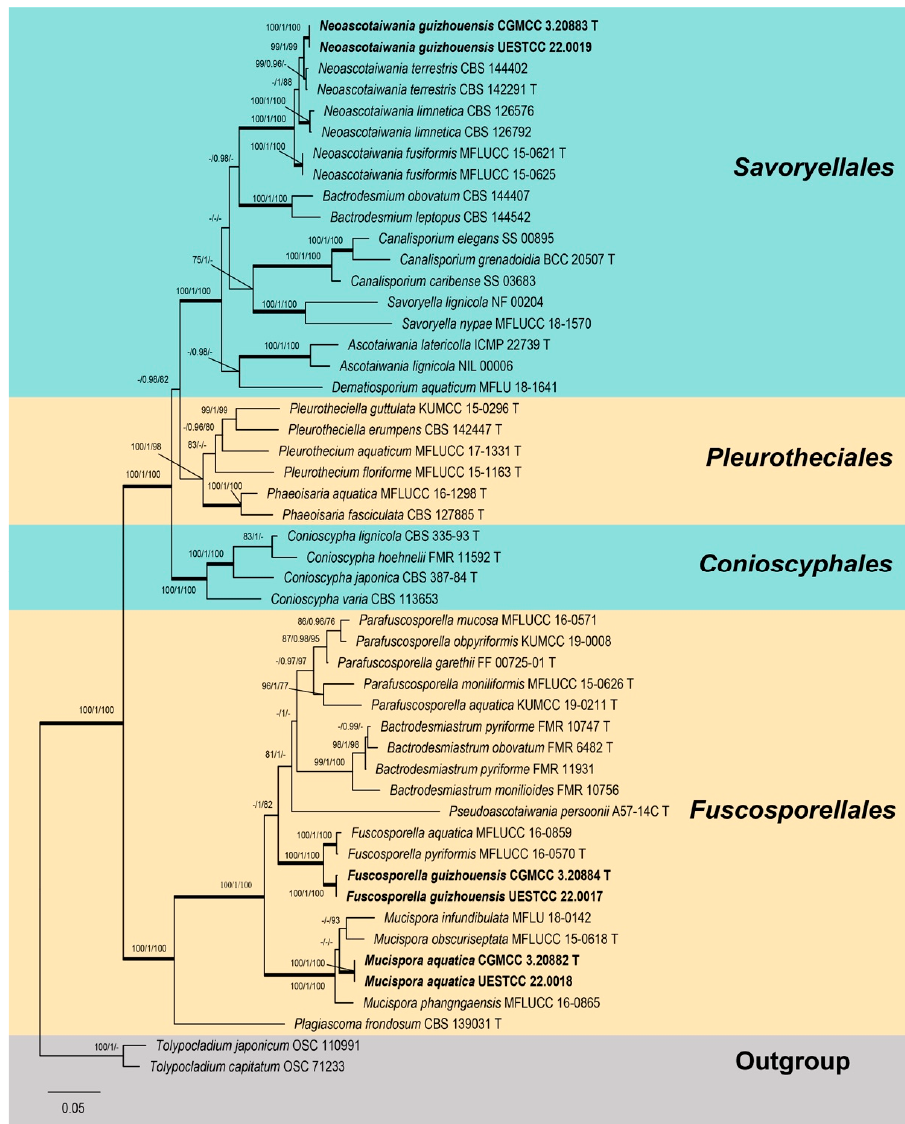
Figure 1. Phylogenetic tree based on the combined LSU, SSU, ITS, RPB2 and TEF1 α sequences constructed by maximum likelihood (RAxML) of selected members of Savoryellomycetidae (Sordari- omycetes). Thickened branches indicate branch support with MLBS = 100%, PP = 1 and MPBS = 100%. Branch support for ML and MP greater than 75% and BI greater than 0.95 are marked above or below branches as MLBS/PP/MPBS. The abbreviation T indicates the ex-type strain. Species’ names and culture collections in bold are newly collected taxa. The tree was rooted with Tolypocladium capitatum (OSC 71233) and T. japonicum (OSC